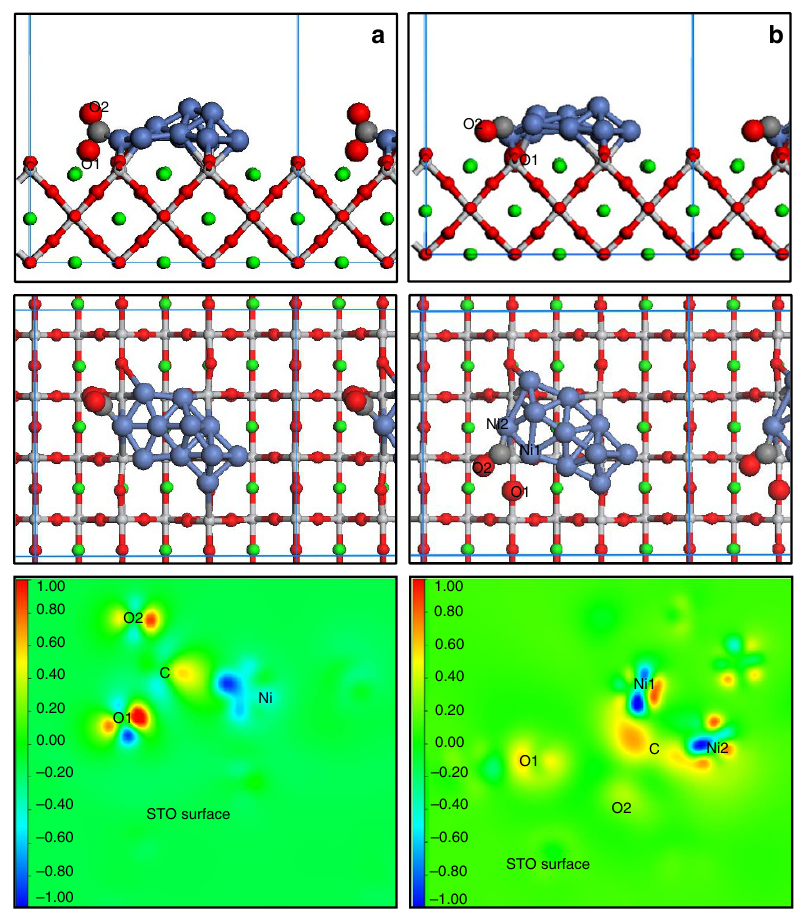
Figure 4 | Theoretical calculations. Different adsorption configurations of CO 2 on ( a ) the (110) Ni/STO system surface and ( b ) defected site of the (110) Ni/STO system surface. The upper panels show side views while the middle panels give top–down views. Unit cells used in the calculations are marked by blue rectangles. Nickel is blue, strontium is green, titanium is pale, oxygen is red and carbon is grey. The bottom panels show contour plots of the electronic charge density difference for CO 2 adsorption on the (110) Ni/STO system surface (bottom left) and defected site of the (110) Ni/STO system surface (bottom